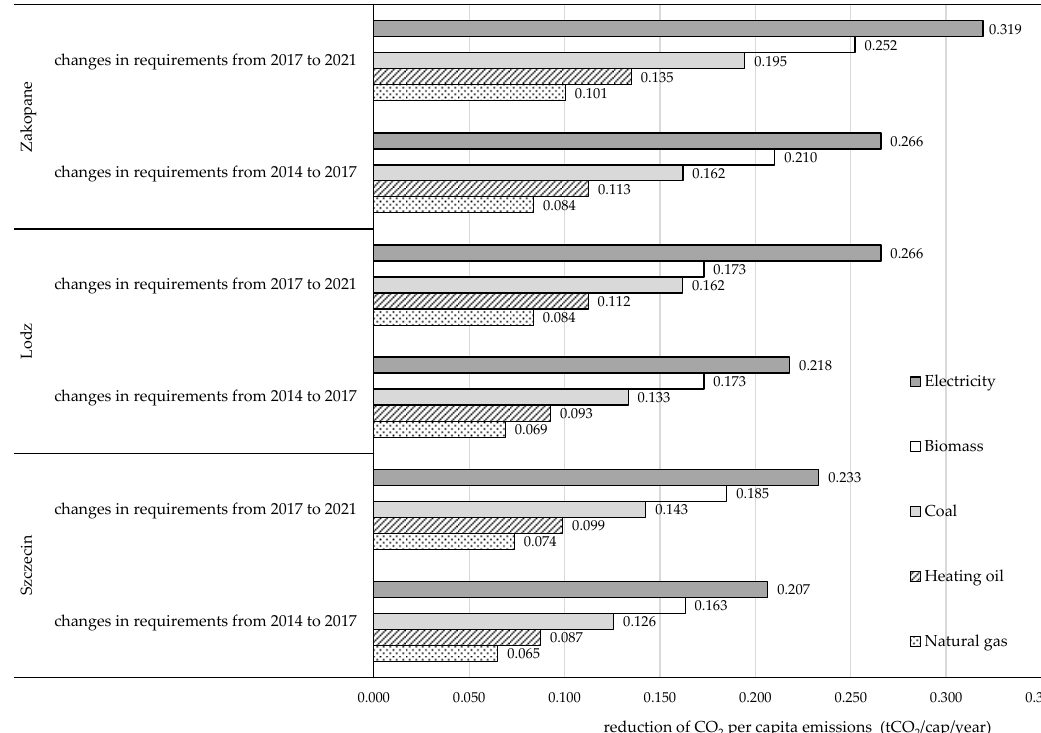
Figure 4. Reduction of CO 2 per capita emissions in the analyzed variants (own elaboration). However, it is not only carbon dioxide that affects the quality of the environment. The article also determines the reduction of emissions of main air pollutants in Poland (SO 2 and NO x ) as a result of changes in the required values of the thermal transmittance coefficient in the building envelope. The results of the calculations are presented in Table